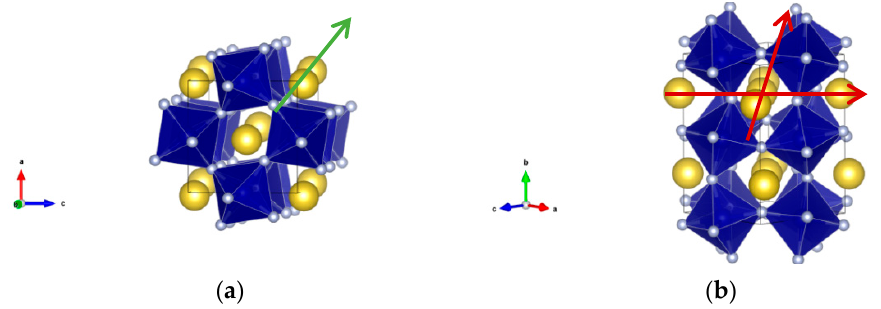
Figure 2. Crystal structures of NaMF 3 , showing the presence of preferential diffusion paths for Na ion diffusion: ( a ) along the crystallographic axis b (green); and ( b ) within the ac plane (red).